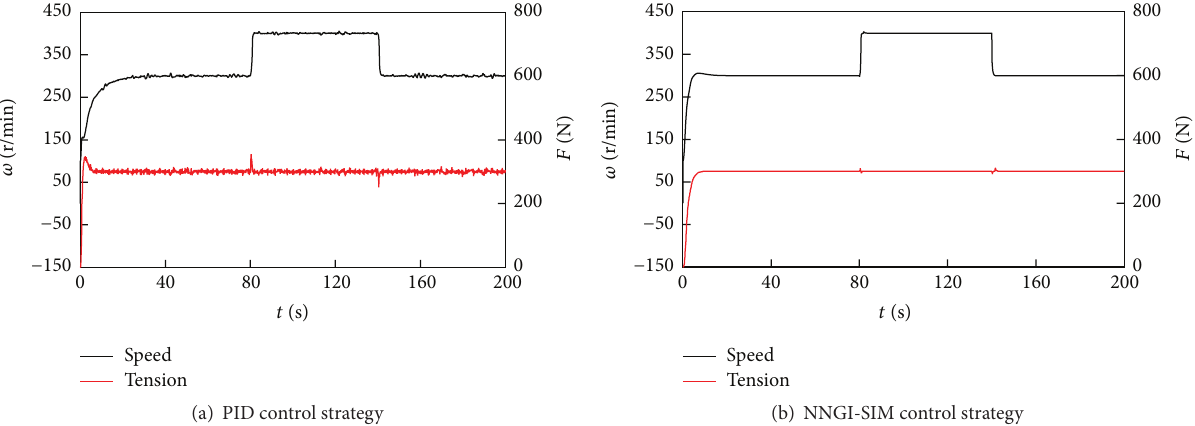
Figure 7: Simulated responses when 𝜔 𝑟1 suddenly changes.